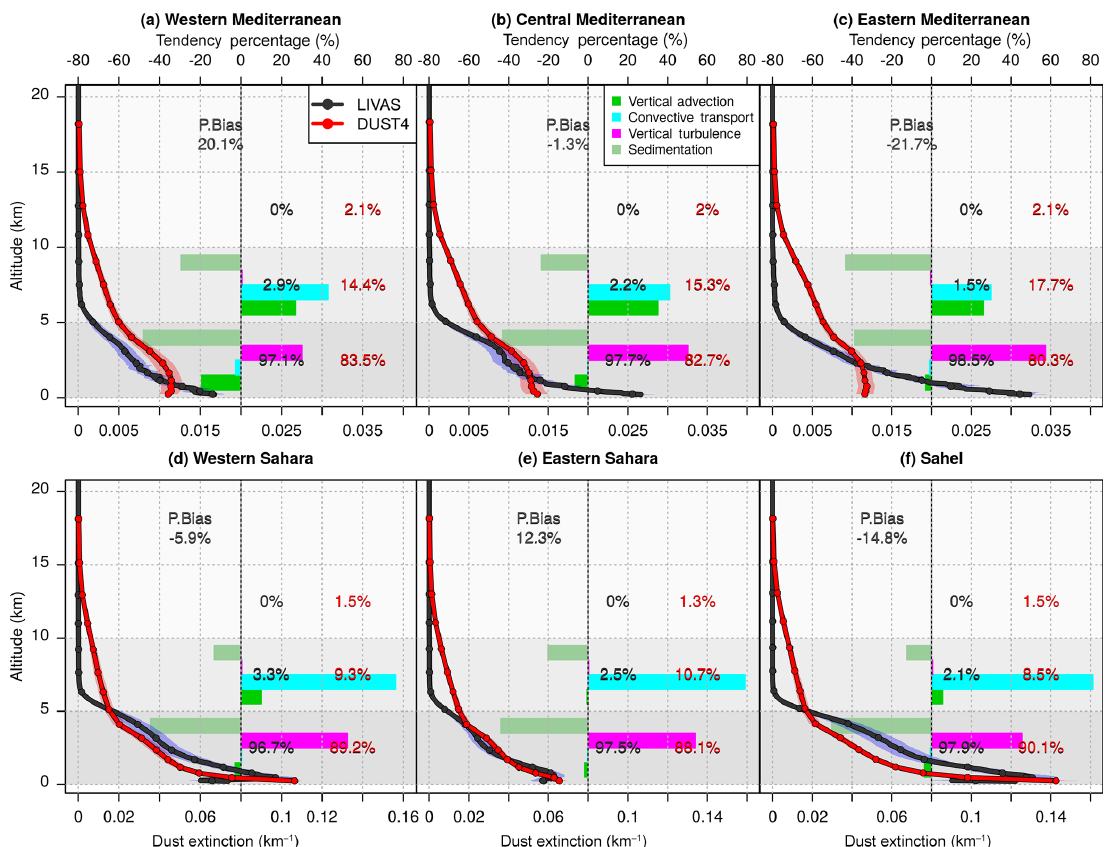
Figure 10. Dust extinction profiles of LIVAS and the DUST4 experiment. The percent bias (P.Bias) of dust extinction between 0.2 and 5, 5 and 10, and 10 and 20km for each subregion is illustrated on the plots. The bars depict the percent of the vertical tendencies for 0.2–5 and